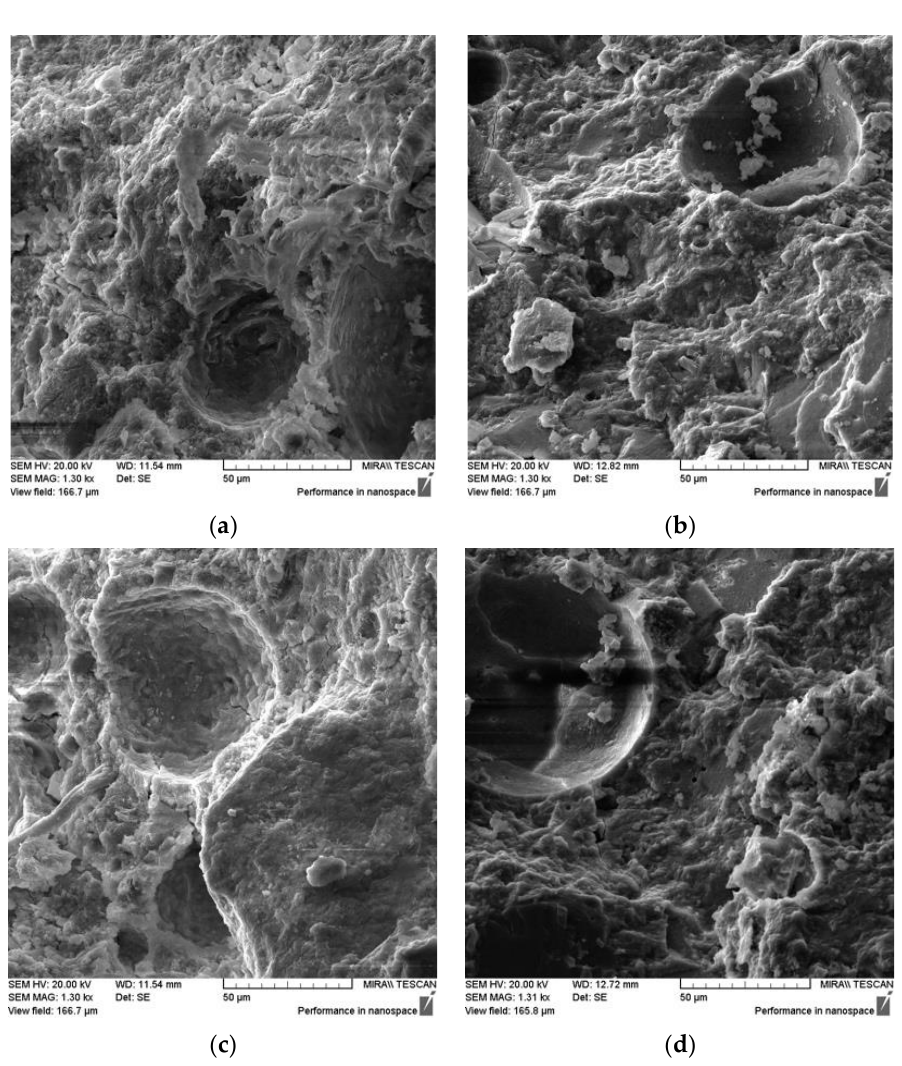
Figure 19. ( a ) treated hemp fibre-reinforced concrete at 30 days, ( b ) treated hemp fibre-reinforced concrete after >90 days, ( c ) treated flax fibre-reinforced concrete at 30 days, ( d ) treated flax reinforced concrete after >90 days.